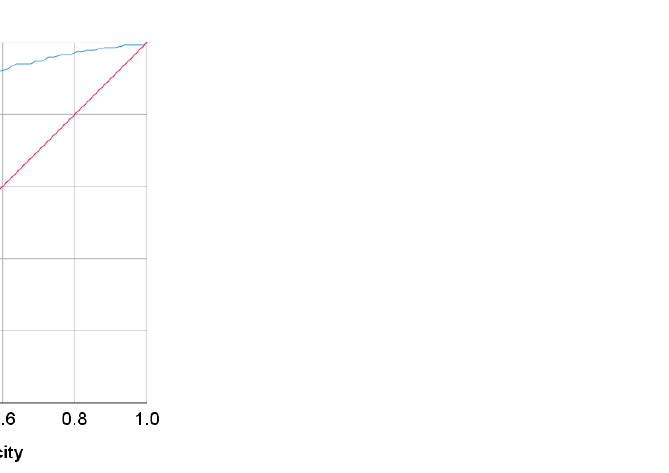
Figure 10. ROC curve for 2hPG values as a screening test on the US-PIMA Indian adult population; 2hPG was used as the gold standard; the straight line represents the reference line.